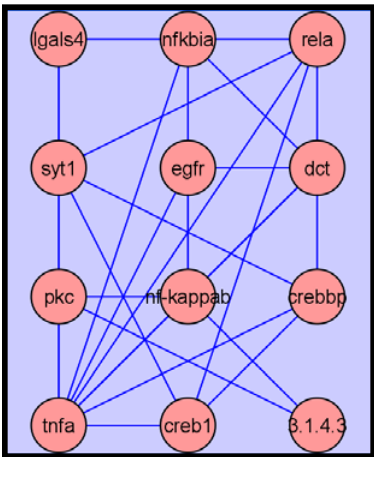
Figure 5. Network interactions depicted among putative biomarkers showing that tumor necrosis factor- α (TNF- α ) and nuclear factor  B (NF-  B) genes had the most connections to other